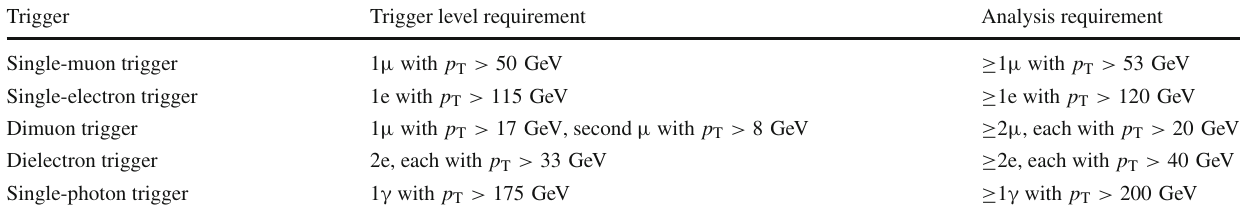
Table 3 Summary of online and offline criteria